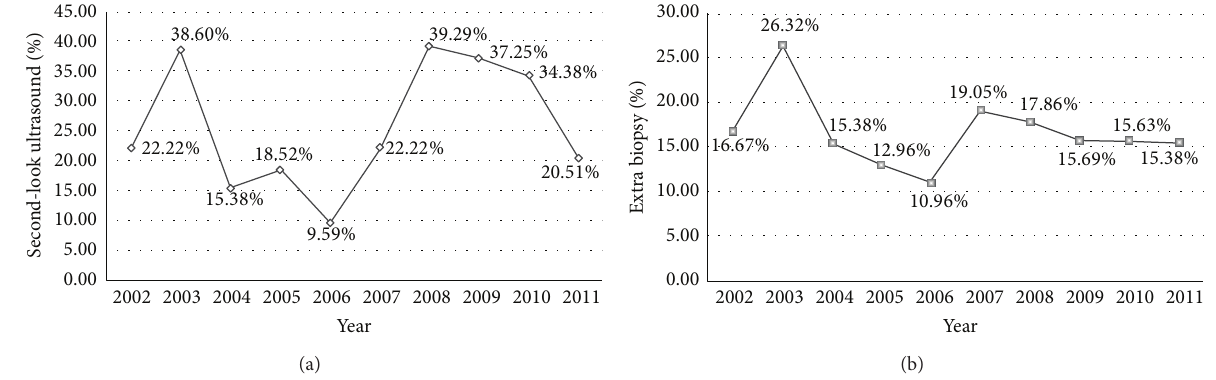
Figure1:(a)Percentageofsecond-lookultrasoundexaminationreferralsinGroupB,peryear,throughoutthereferenceperiod.(b)Percentage of additional biopsy referrals in Group B, per year, throughout the reference period.